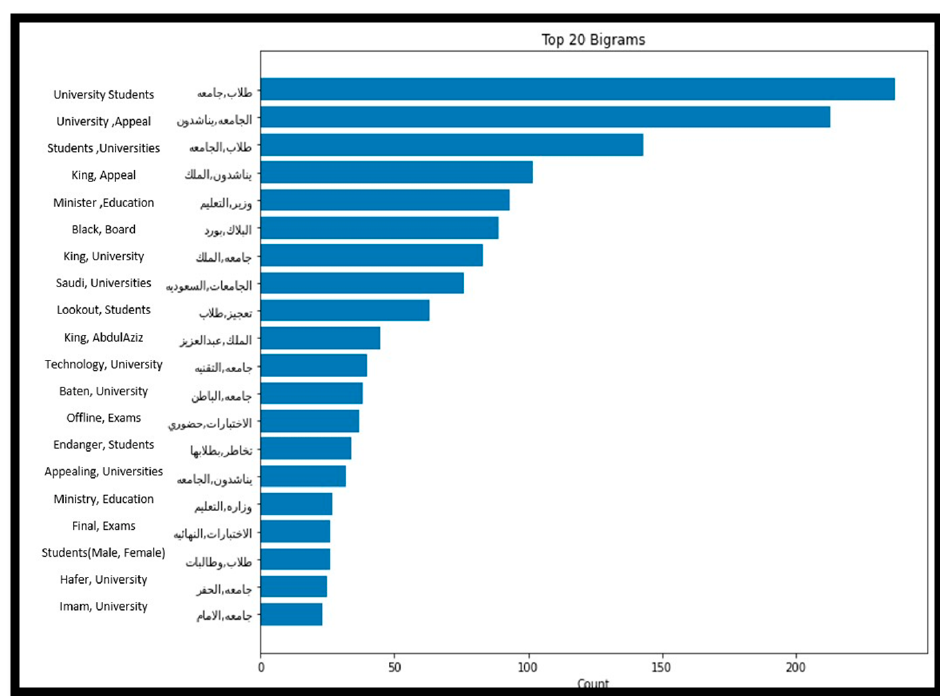
Figure 7. Top 20 Frequent words from the university’s negative tweets. Regarding the top 20 frequent words for the negative tweets of the unspecified